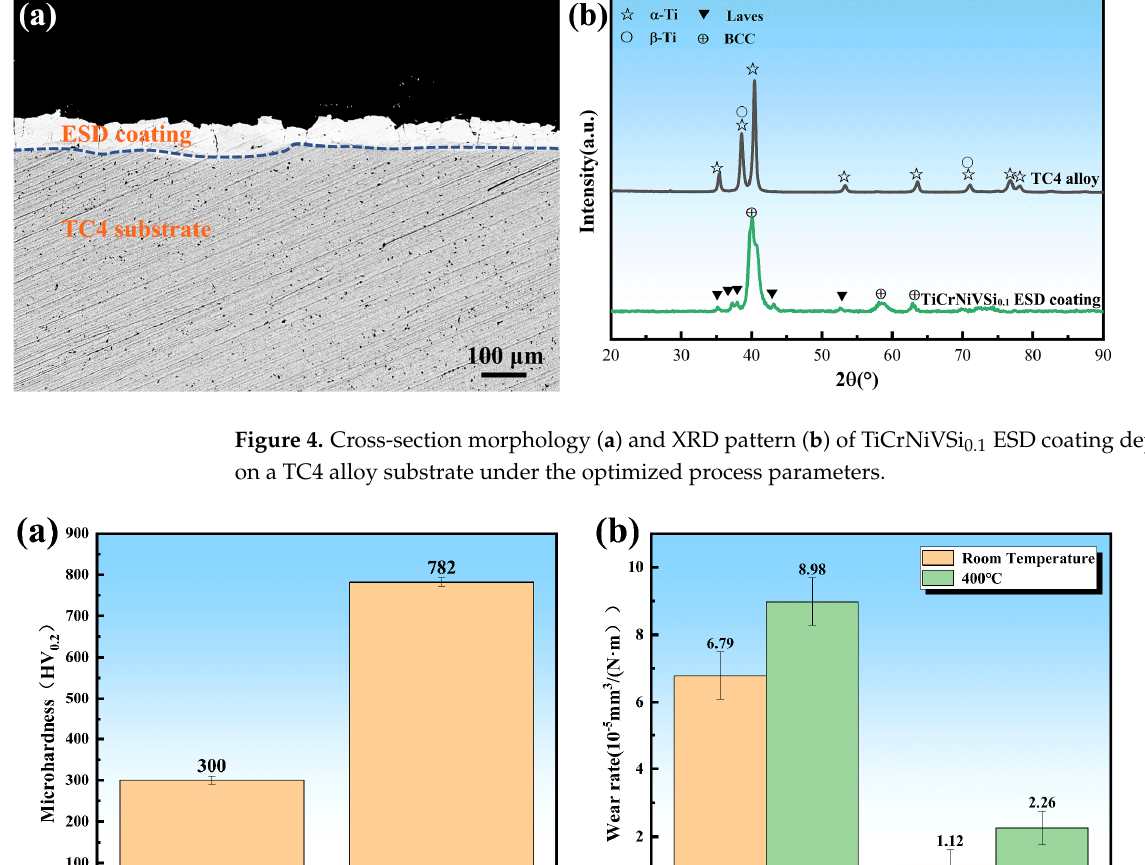
Figure 4. Cross ‐ section morphology ( a ) and XRD pattern ( b ) of TiCrNiVSi 0.1 ESD coating deposited on a TC4 alloy substrate under the optimized process parameters.